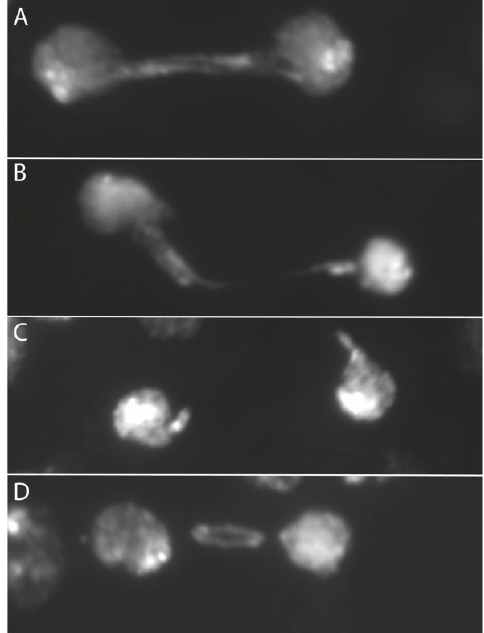
Figure 3. Examples of double dicentric bridges in telophase. Bridges were formed via FLP recombi- nation within a ring chromosome; ( A ) an unbroken double bridge; ( B ) the bottom arm of the double bridge is clearly broken, the other may be intact; ( C ) both arms of the double bridge are broken; ( D ) a lagging bridge.